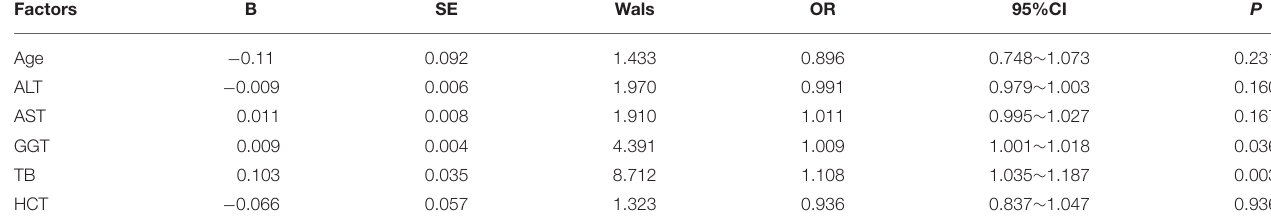
TABLE 3 | Logistic regression analysis on correlative factors of PMP in children.